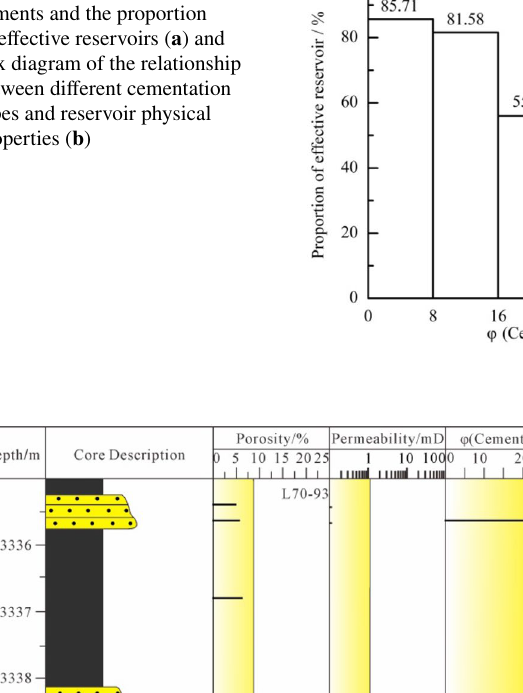
Fig. 10 Relationship between the volume fraction of different cements and the proportion of effective reservoirs ( a ) and box diagram of the relationship between different cementation types and reservoir physical